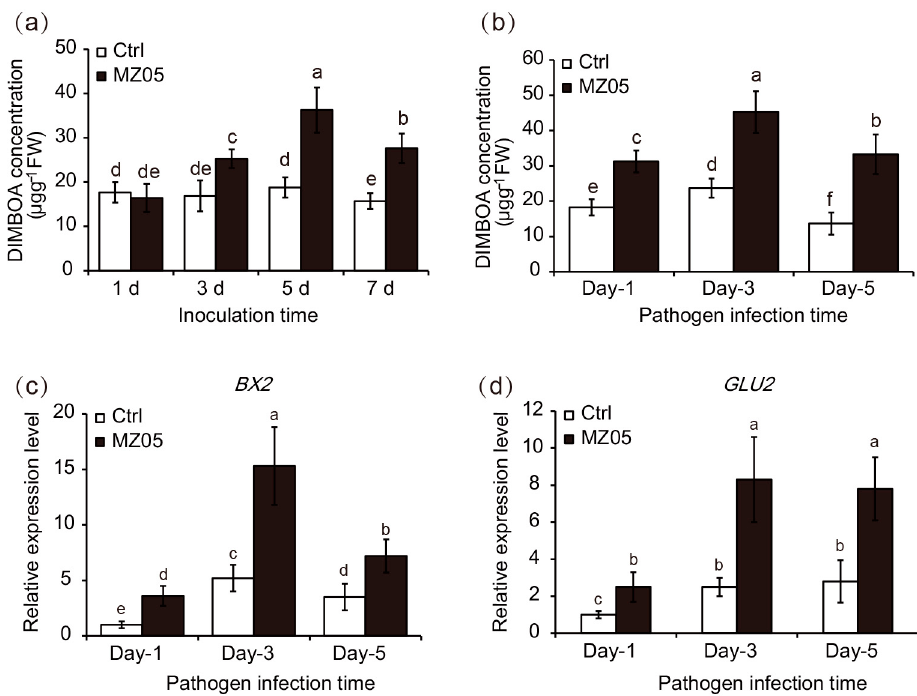
Figure 3. Analyses of the DIMBOA levels and the expression of BX biosynthetic genes in the leaves of maize plants. Four-week-old maize seedlings were treated with or without bacterial suspensions of MZ05 (1 × 10 8 CFU/g soil). The fourth leaves harvested from different inoculation times were then used to measure the levels of DIMBOA ( a ). After 7 days of inoculation, these plants were subjected to the infection of S. turcica at 5 × 10 4 conidia mL -1 . At the indicated time points of pathogen infection, leaf samples were harvested to measure the content of DIMBOA ( b ). Meanwhile, the expression levels of BX2 ( c ) and GLU2 ( d ) were also quantified in the pathogen-infected leaves. Different letters indicate statistically significant differences between the control (Ctrl) and inoculated (MZ05) plants using one-way analysis of variance and Ducan’s tests ( p < 0.05).